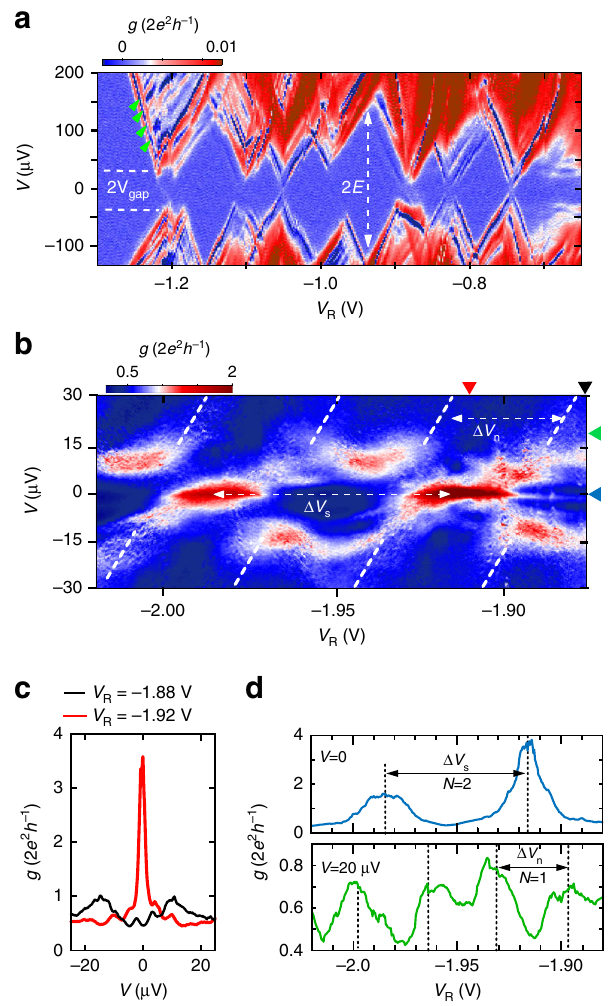
Fig. 4 Charge island in regimes IV and III. a Conductance diamonds measured in regime IV with voltage bias V on the vertical axis. E denotes the addition energy of the island. The diamonds exhibit a gap of V gap ≈ ±30 μ V. Green arrows indicate signatures of excited states due to quantum con fi nement. Note that due to gate history effects, this regime occurs at a lower V R range. b g measured in regime III. For small voltages g exhibits peaks with periodicity Δ V s = 70 mV. For V > 15 μ V the periodicity increases by a factor 2, Δ V n = 35 mV (dashed white lines). Black, red triangles and blue, green triangles indicate the line cuts shown in c , d , respectively. c vertical line cuts from b at V R = − 1.88 V and V R = − 1.92 V. d Horizontal line cuts from b at V = 0 (top panel) and V = 20 μ V (bottom panel).